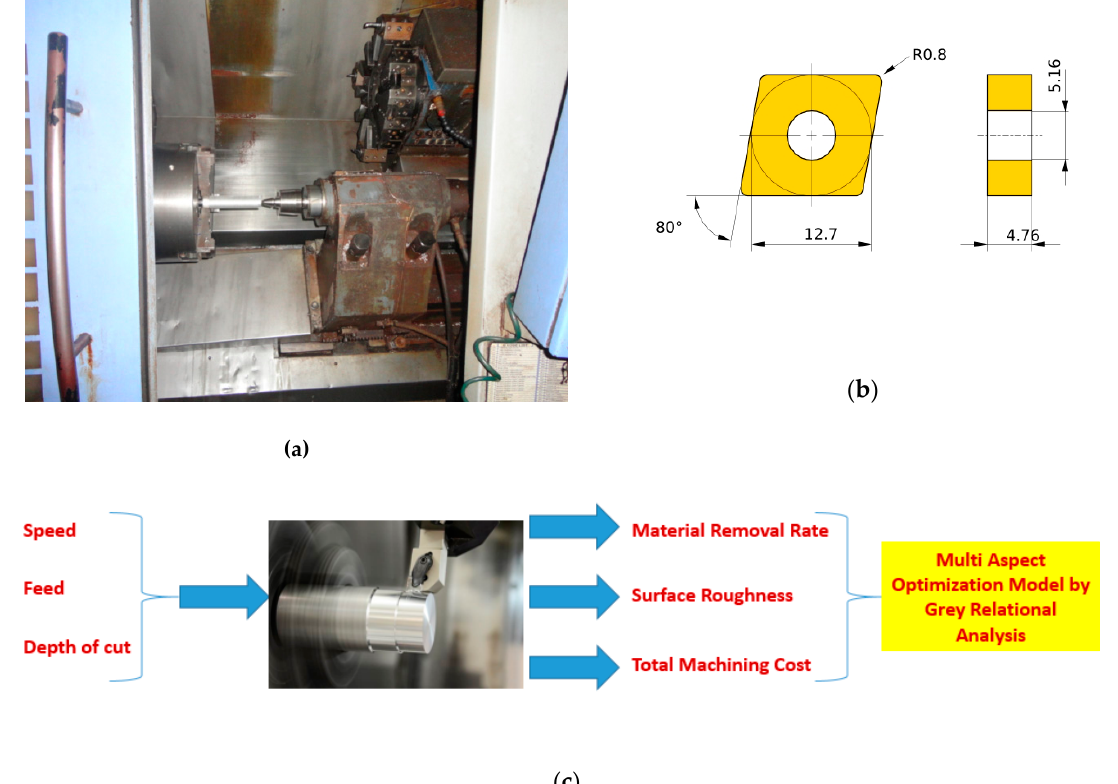
Figure 1. ( a ) Experimental setup with ( b ) tool geometry in mm CNMG120408-GM and ( c ) procedural steps of the turning of LM steps of the turning of LM 25.